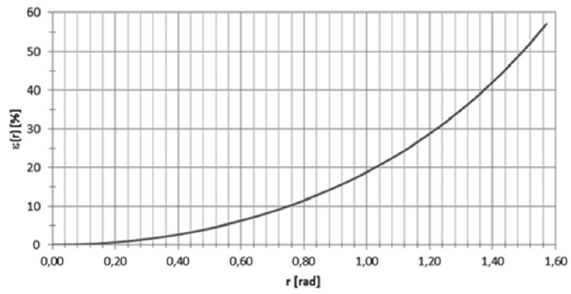
Fig. 14. The graph of relative error (cid:72) ( r ) for the spherical circle of radius